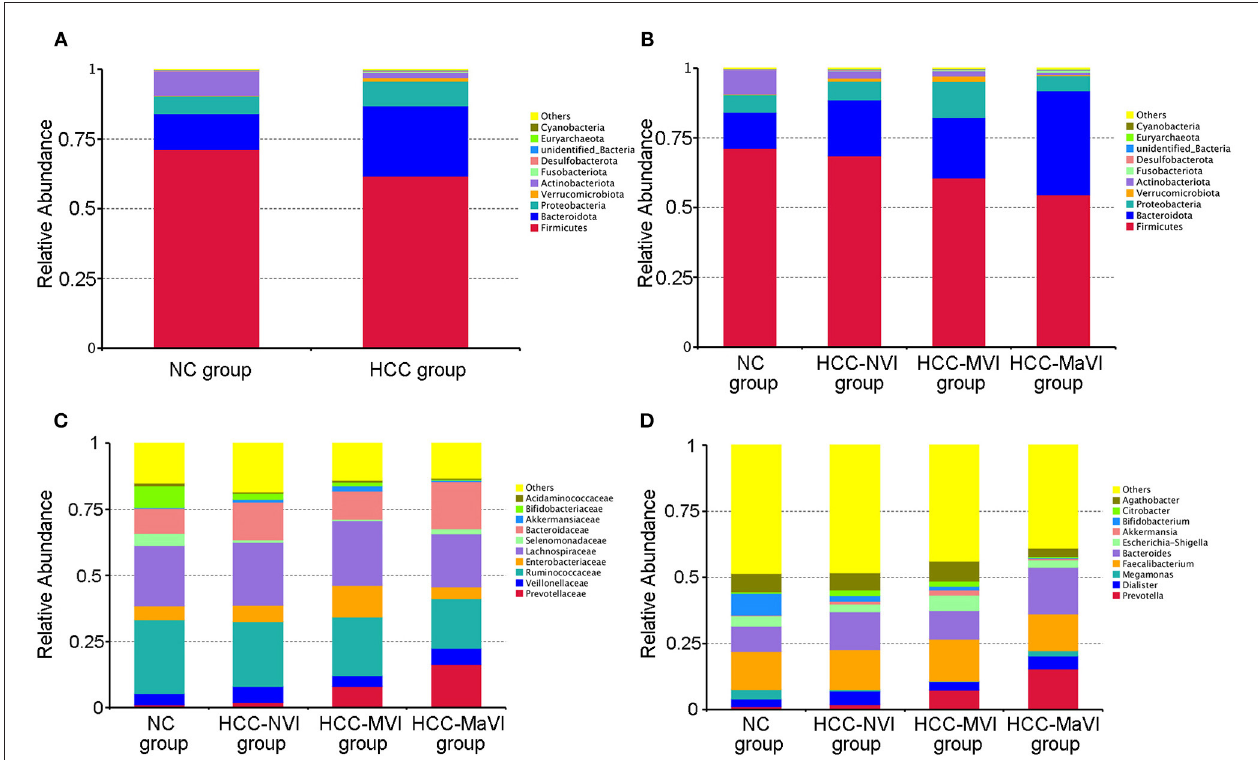
FIGURE 4 | Relative abundance of microbiome across different groups. (A) The heatmaps of the NC and HCC bacteria groups at the phylum level. Heatmaps of the NC, HCC-NVI, HCC-MVI, and HCC-MaVI bacteria groups at the phylum level (B) , at the family level (C) , at the genus level (D) .